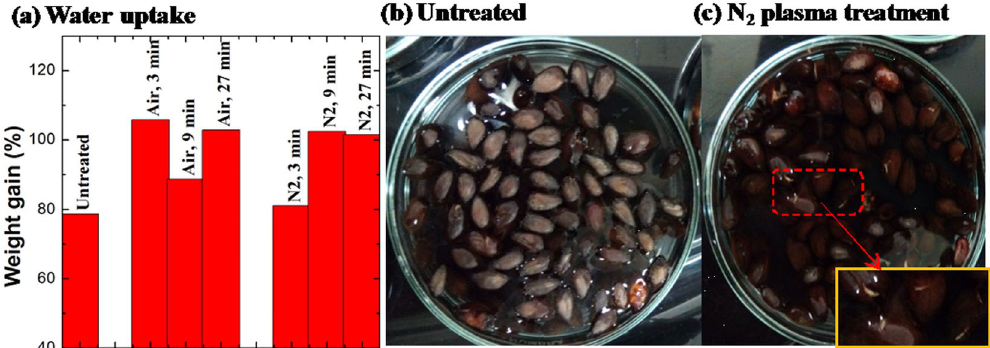
Figure 5. ( a ) Water uptake by seeds treated with air and N 2 plasmas, represented as a weight gain after immersion in water for 20 h, and germination pictures of ( b ) untreated seeds and ( c ) N 2 plasma treatment seeds. Inset: Germination is evident in the seeds treated by plasma, but not in those in the control group where a substantial number of seeds float on the